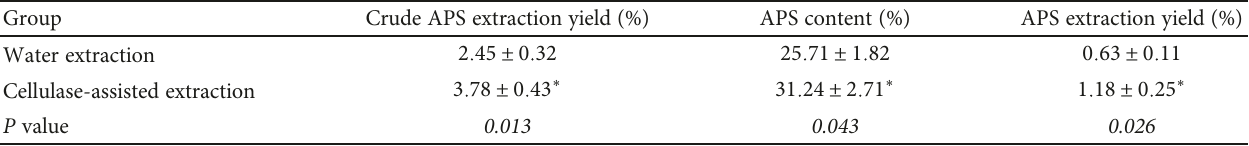
Table 1: Yield and content of Astragalus polysaccharides extracted by di ff erent methods. Group